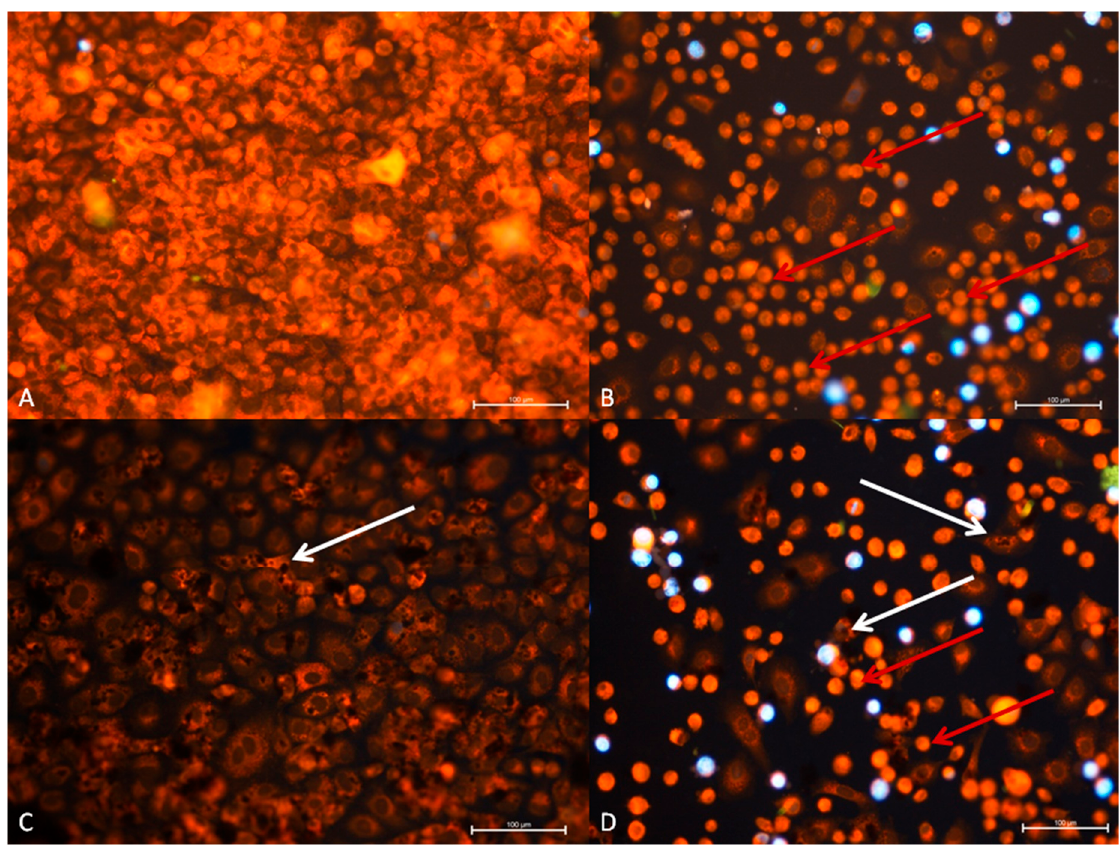
Figure 7. A549 (ATCC ‐ CCL ‐ 185TM) cell line 24 h after administration of virus and GO. ( A ) Control group, ( B ) RuV group, ( C ) GO group, ( D ) RuV + GO group. Normal cells show regular, oval shape with nucleus present in the middle of the cells. Peripheral cytoplasm is well visible. In response to the RuV cytopathic effect is noted in most of the A549 cells line. Cells have reduced volume, with cytoplasm condensed around nucleus. In GO group dark aggregates are present inside and covering cells (white arrow). DAPI and Rhodamine B. Mag 100x. Scale bar 100 μ m.